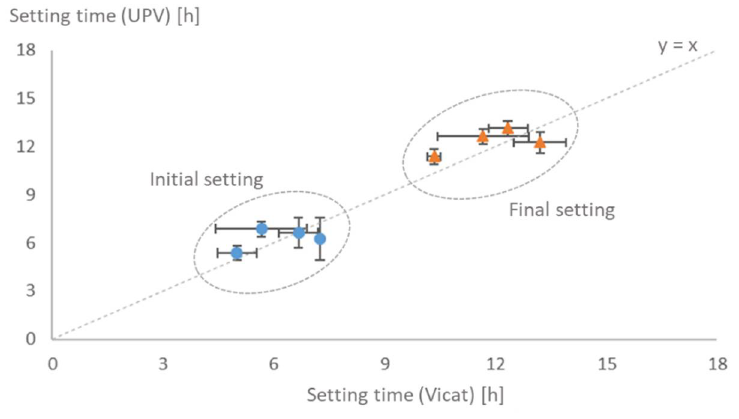
Figure 3. Comparison between setting times determined by Vicat and UPV methods.